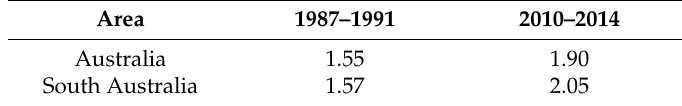
Table 1. Inequality rate ratio for Australia and South Australia 1